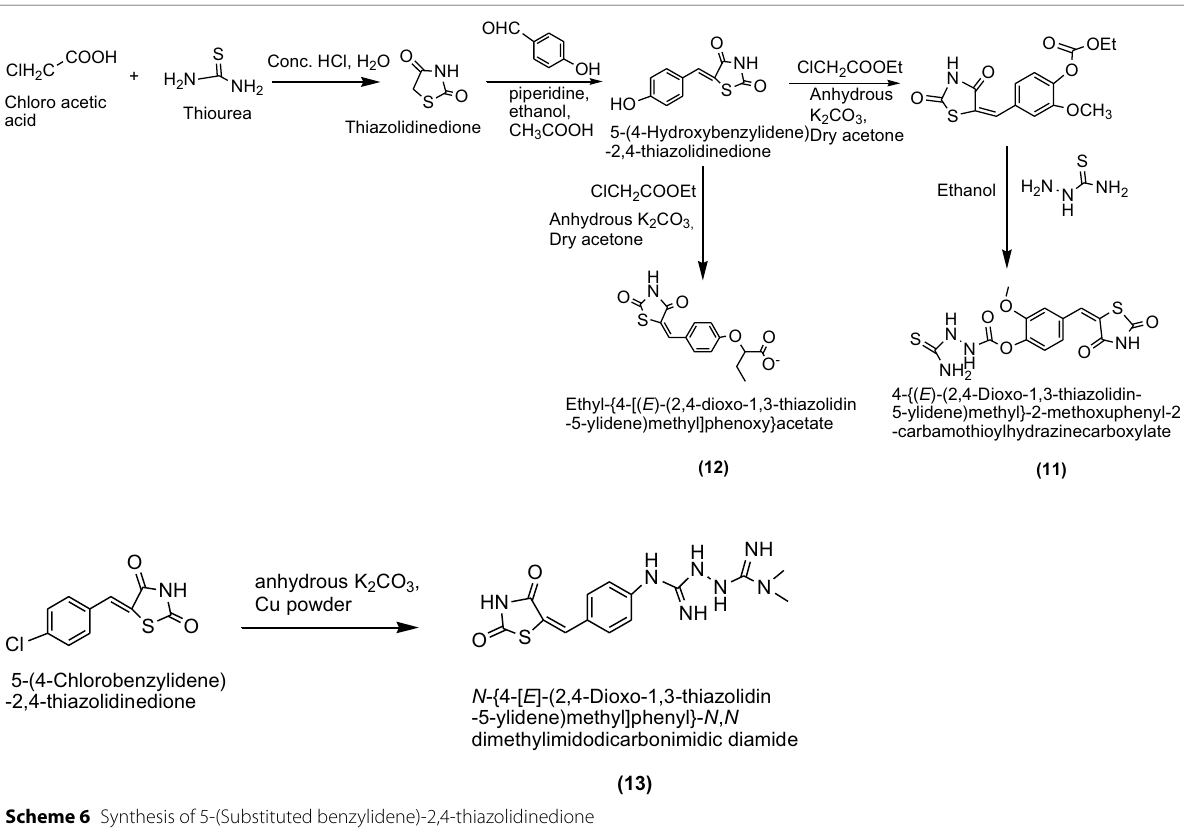
Table 6 Hypoglycemic effect of synthesized compounds Compounds Blood glucose level mg/dl (mean